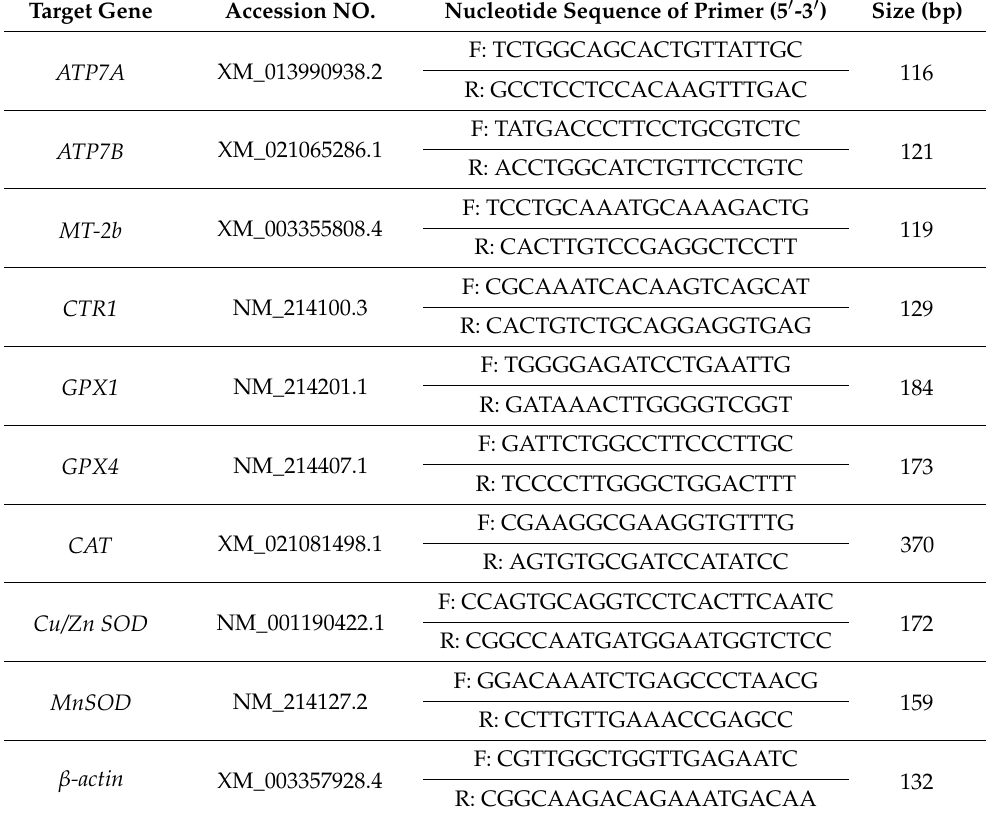
Table 2. Cont. Target Gene Accession